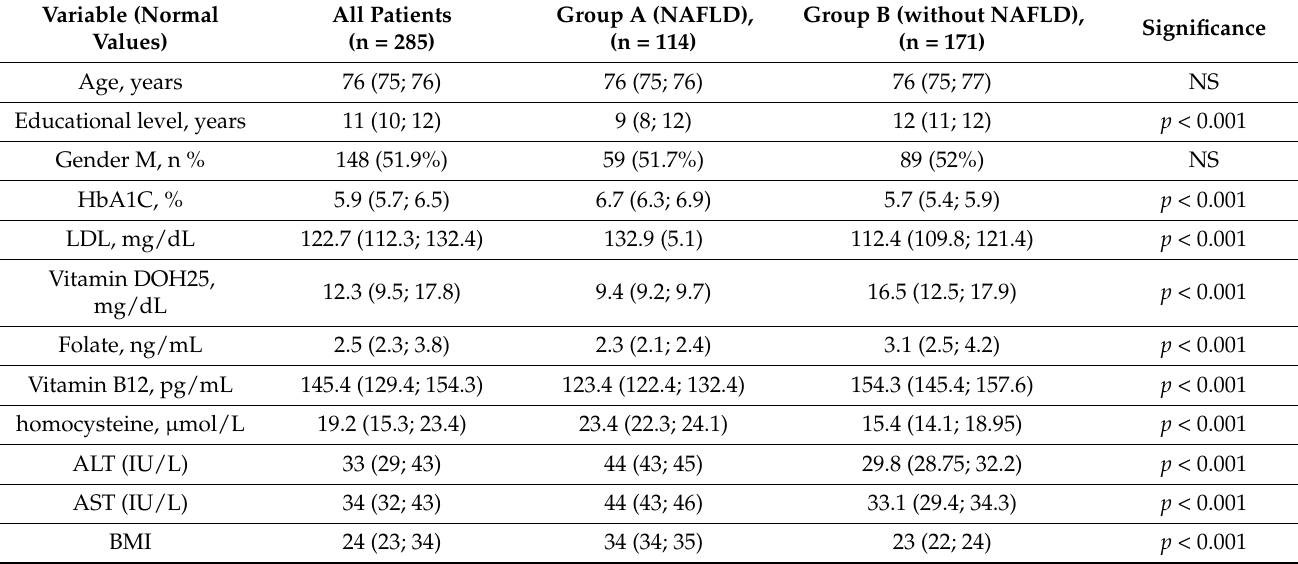
Table 1. Clinical, biochemical, and Anthropometric characteristics of the enrolled population ( n = 285). Continuous variables are reported by median and interquartile ranges (IQR). Patients are stratified by presence ( n = 114) and absence ( n = 171) of